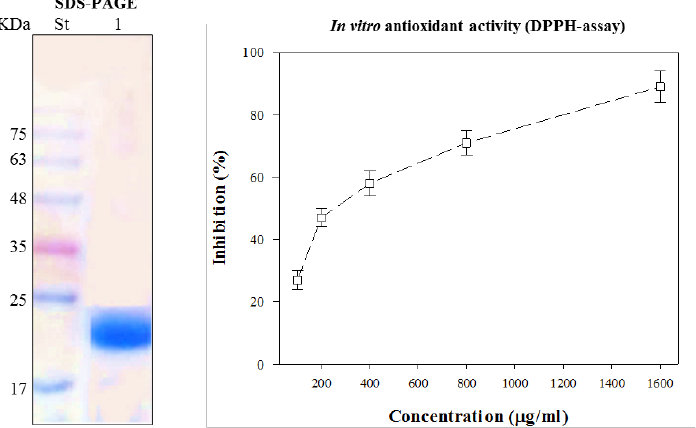
Figure 1. SDS-PAGE electrophoretic pattern of the purified catfish glycoprotein (Lane 1) compared to the standard molecular weight (St) and its antioxidant activity at different concentrations (100, 200, 400, 800 and 1600 µg mL −1 ), as measured by a DPPH assay. Every value is the average of three replicates ± SD.